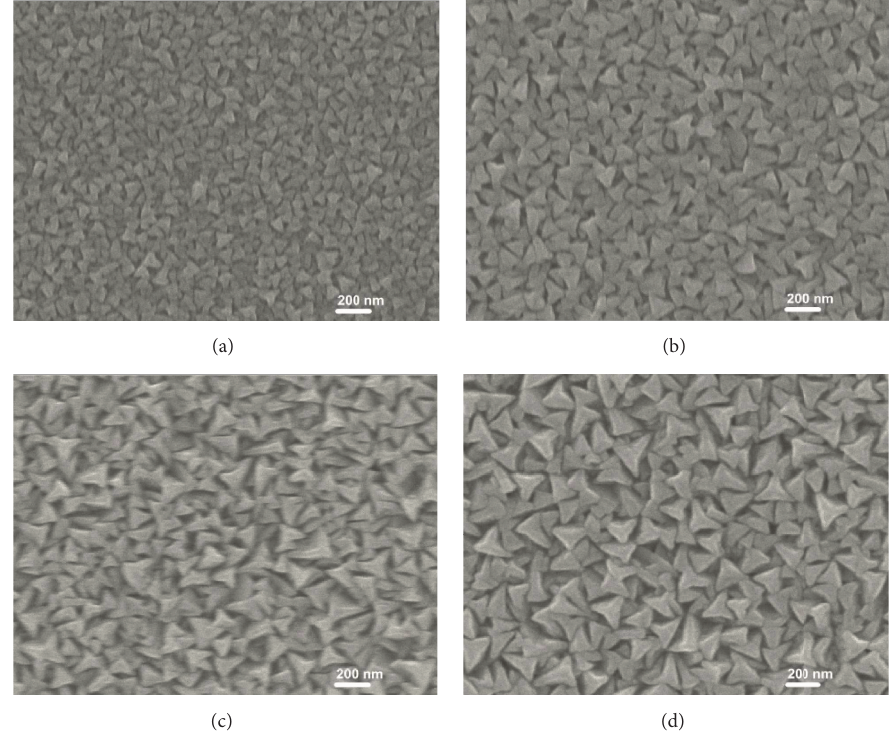
Figure 4: Surface morphology of ZnO films at various thicknesses: (a) 212 nm, (b) 422 nm, (c) 652 nm, and (d) 766 nm. The deposition temperature was 146 ∘ C.